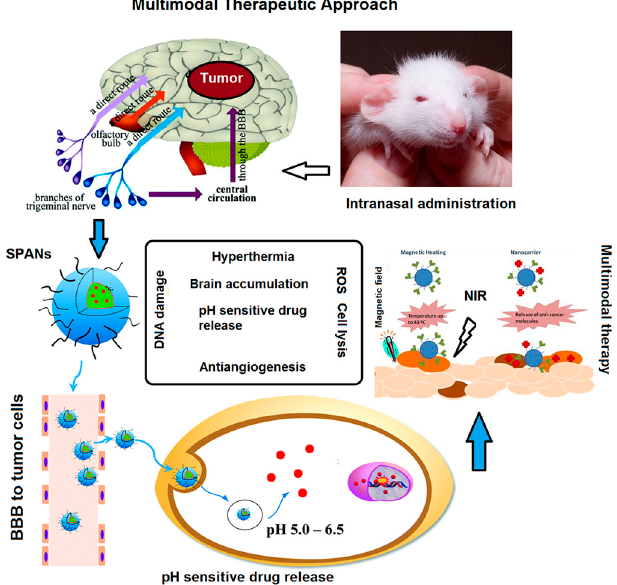
Figure 6. Effectiveness of hyaluronic acid ‐ based pH ‐ responsive alloy–drug nanoconjugates for Figure 6. E ff ectiveness of hyaluronic acid-based pH-responsive alloy–drug nanoconjugates for glioblastoma treatment. Reproduced with permission from [73]. Elsevier (2019). glioblastoma treatment. Reproduced with permission from [73]. Elsevier